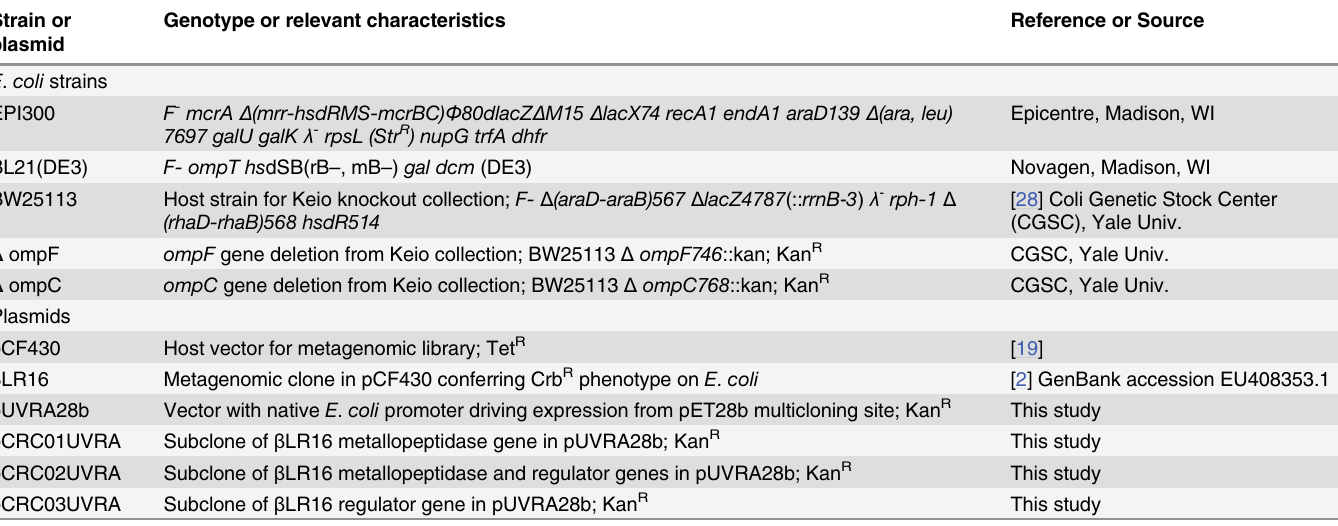
Table 1. Strains and plasmids used in this study.